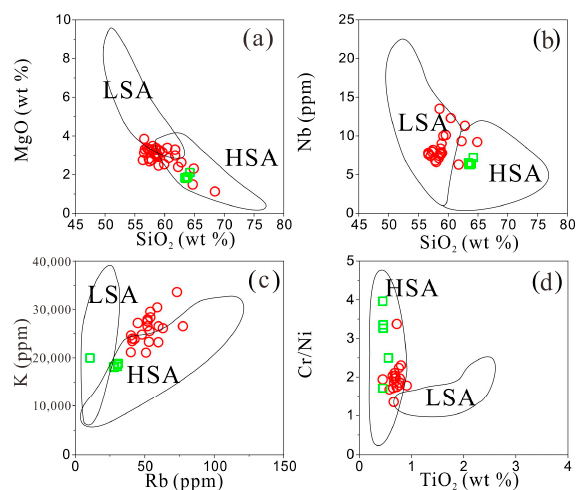
Figure 12. Comparison of HSA and LSA. Ranges of HSA and LSA are taken from [17]. ( a ) MgO vs. SiO 2 ; ( b ) Nb vs. SiO 2 ; ( c ) K vs. Rb; ( d ) Cr/Ni vs. TiO 2 . Symbols are as in Figure 4.